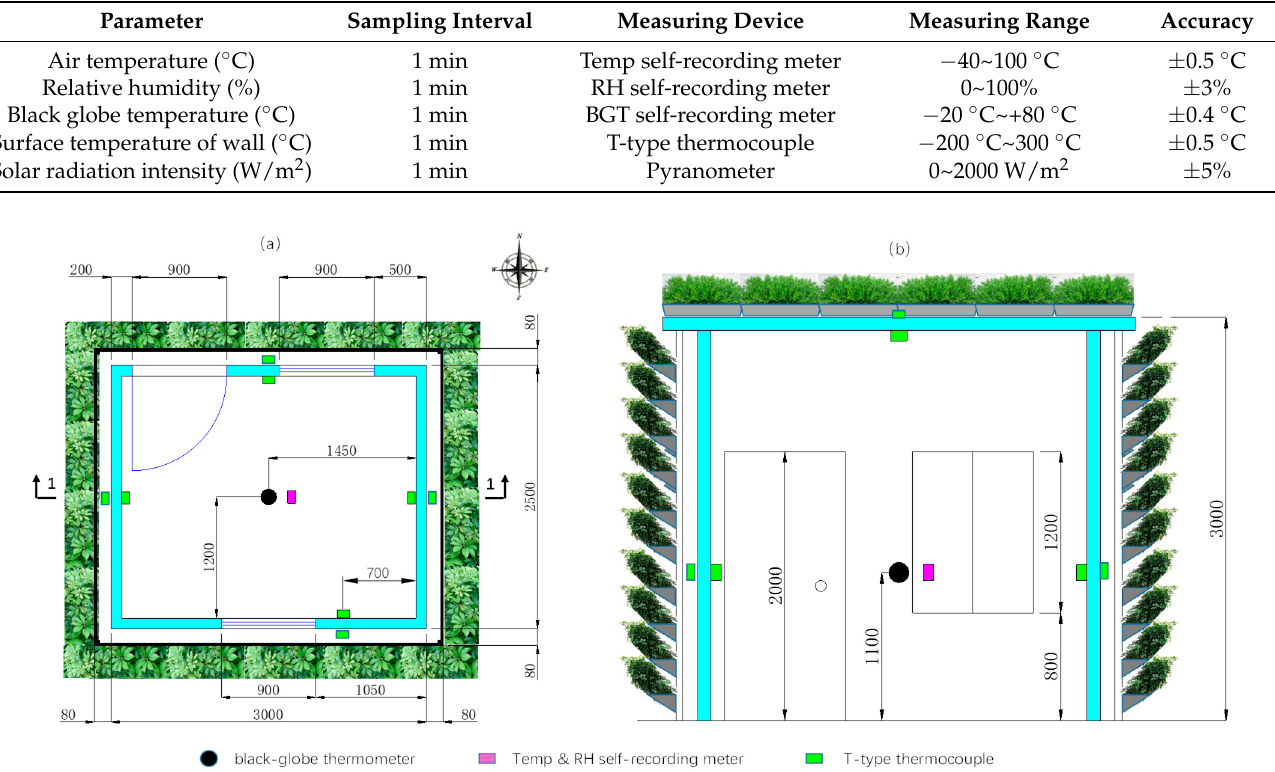
Table 1. Monitoring data and instrumentation.